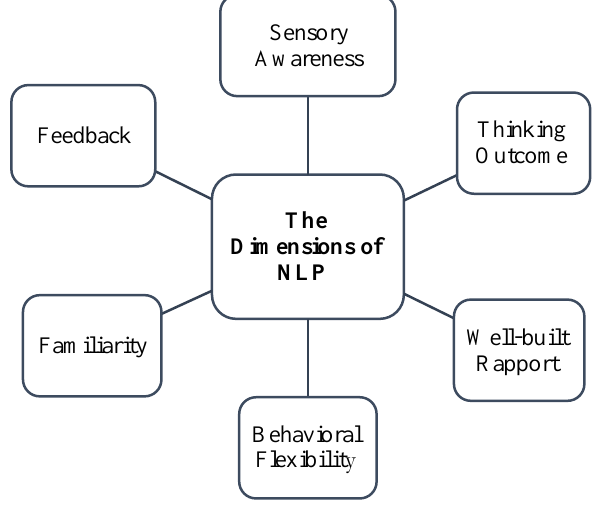
Figure 1. The Dimensions of